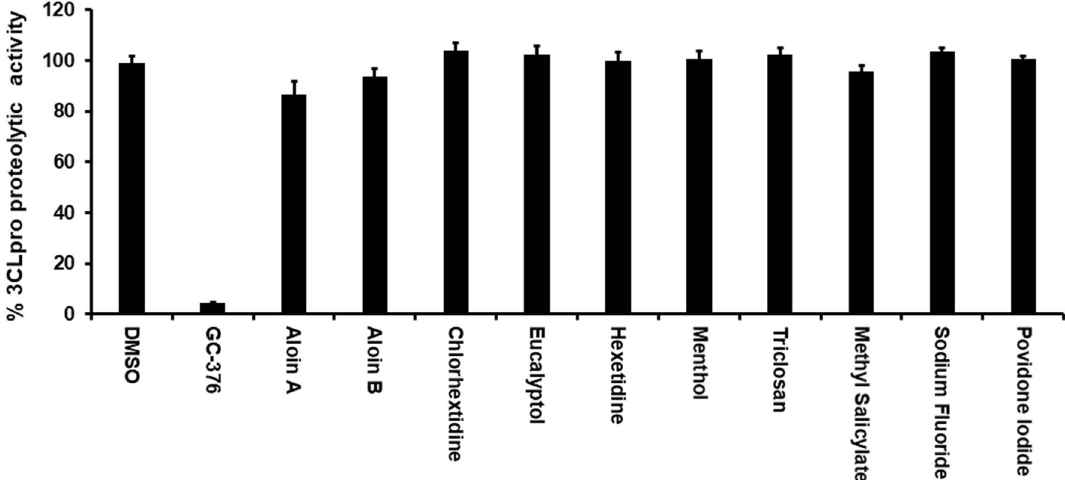
Figure 2. Most of the active ingredients present in the mouth rinses did not exhibit inhibitory activity against SARS-CoV-2 3CLpro enzyme. Aloin A, aloin B, chlorhextidine, ecalyptol, hexetidine, menthol, triclosan, methyl salicylate, sodium fluoride and providone iodide were selected for their inhibitory activity against SARS-CoV-2 3CLpro enzyme as described under Materials and Methods. The fluorescence intensity was used to calculate the percent enzymatic activity considering DMSO treated control as 100% activity. Blank values were subtracted from before calculating the percent activity. DMSO (0.1%) with enzyme and 50 µM of substrate served as positive control. Wells with 50 µM of GC-376 served as specificity controls for 3CLpro. Representative of three experiments (n = 3) with triplicate values were presented graphically. P value < 0.001 considered as statistically significant. One-way ANOVA with Bonferroni’s Multiple Comparison post-hoc test was used to calculate the statistical